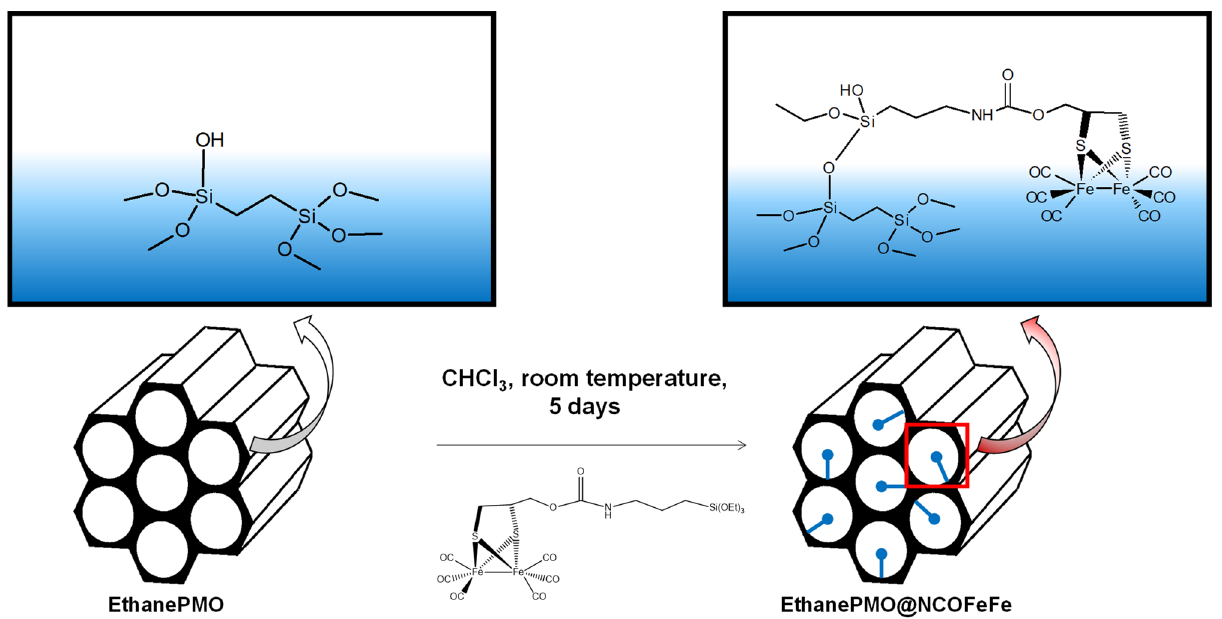
Figure 3. Scheme of the grafting procedure on the ethylene-bridged periodic mesoporous organosilicas (EthanePMO) material with the NCOFeFe precursor.